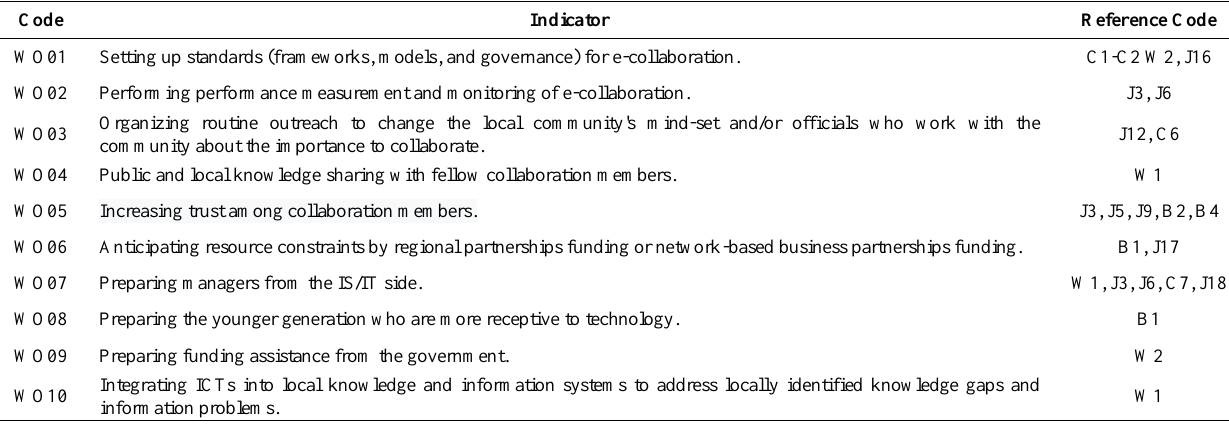
Table 6. The WO Strategy (Weakness-Opportunity Strategy).